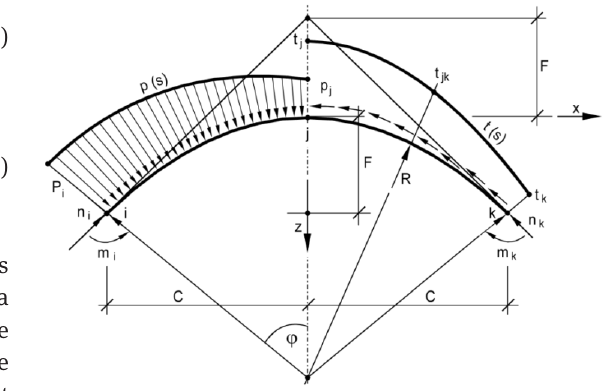
Figure 4 : Designations of internal forces and interfacial interactions in segment of perimeter zone of